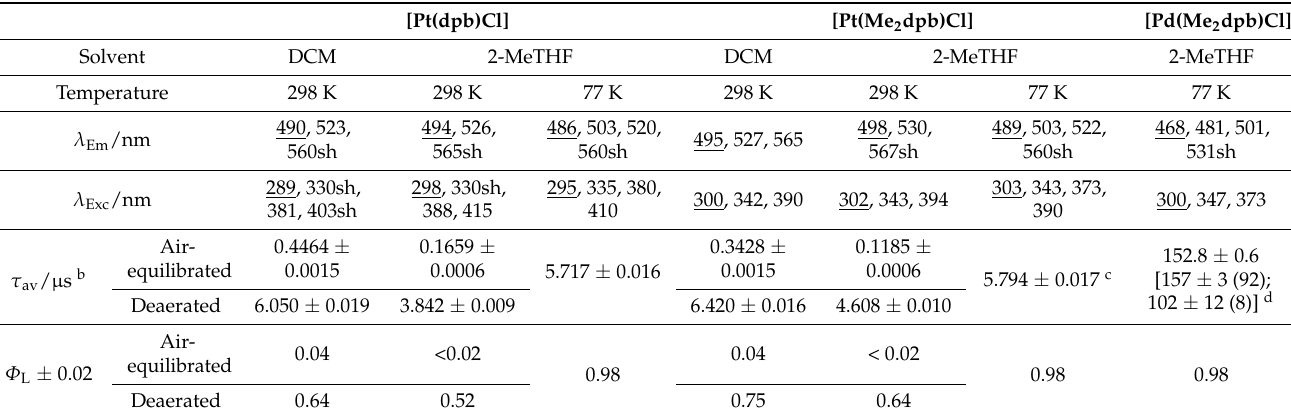
Figure 6. Photoluminescence spectra of [Pt(dpb)Cl] (black), [Pt(Me 2 dpb)Cl] (red), and [Pd(Me 2 dpb)Cl] (blue) in 2-MeTHF at 298 K ( left ) and at 77 K as a glassy matrix ( right ). The Pd complex was not emissive at 298 K. Table 3. Photoluminescence data of the investigated Pt and Pd complexes a